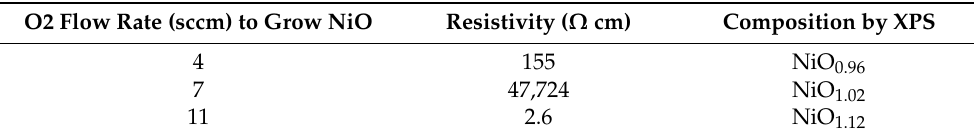
Table 1. Resistivity and compositions of NiO thin films.